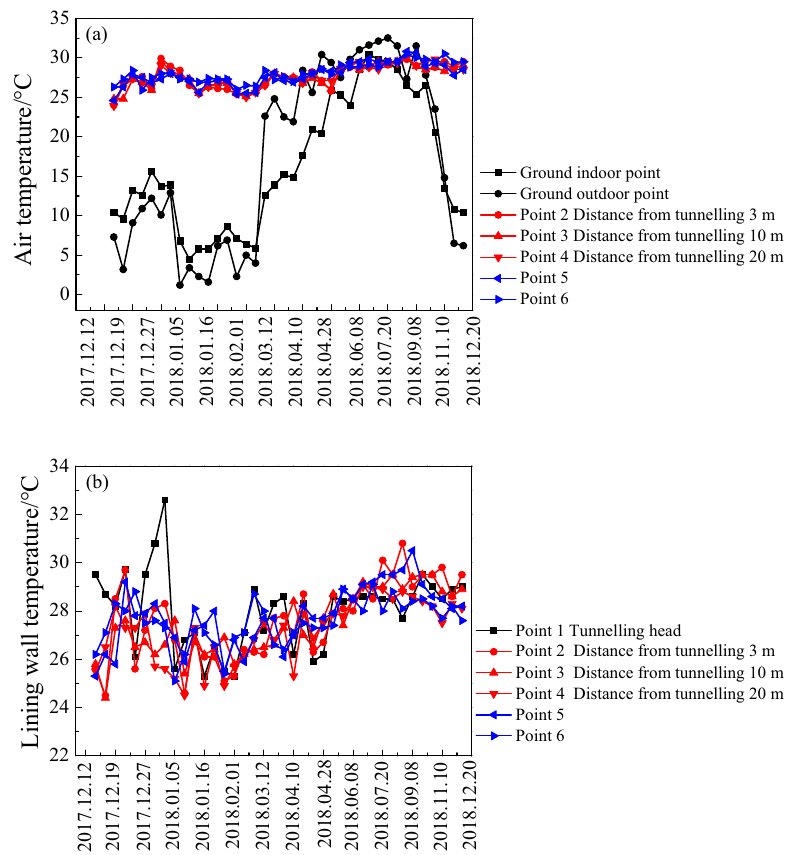
Figure 2: Temperature test results of roadway: ( a ) air temperature; ( b ) wall temperature.